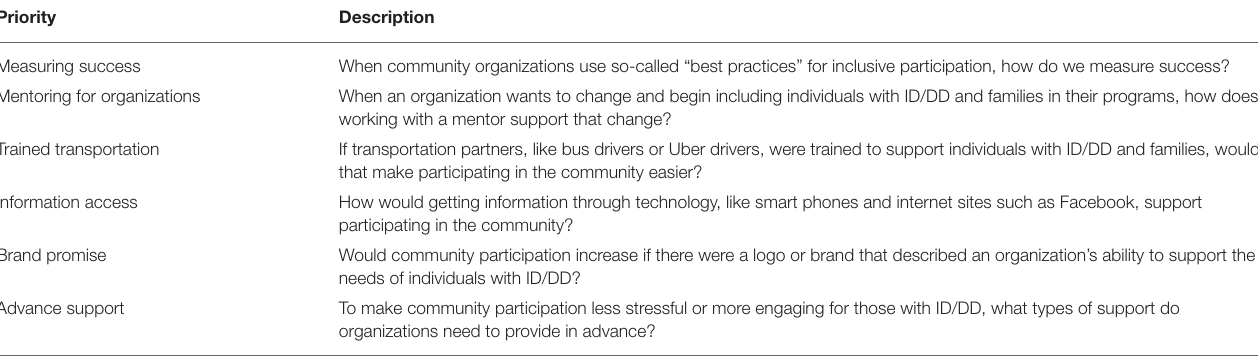
TABLE 3 | Stakeholder research priorities.